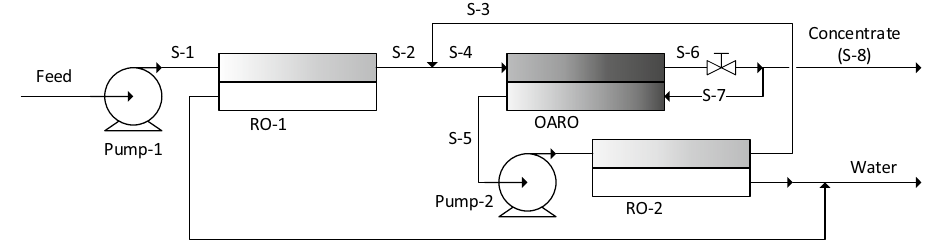
Figure 2. The novel process flow diagram, investigated in this